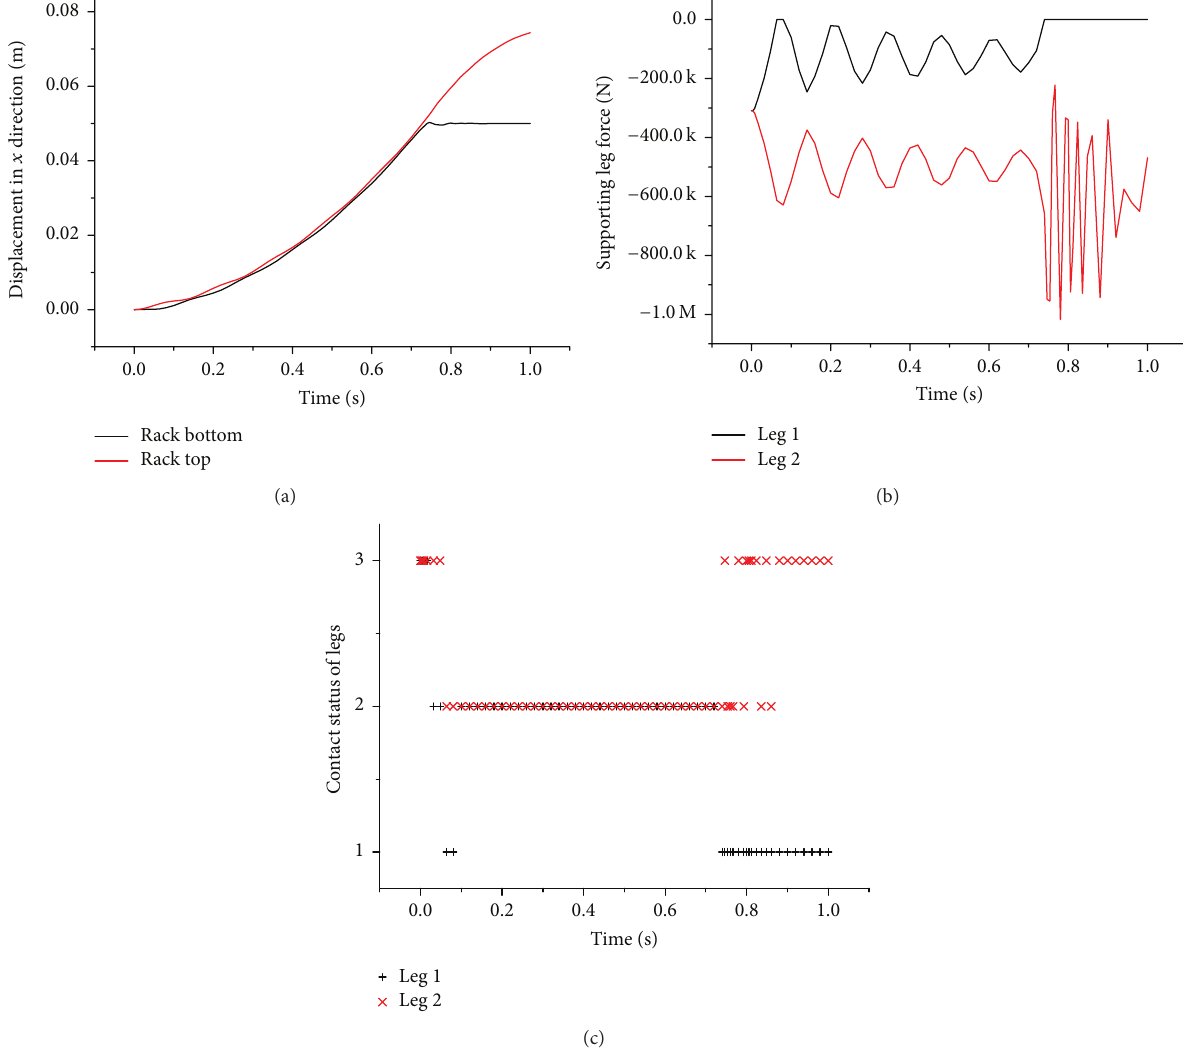
Figure 7: Uniform acceleration amplitude loading: 0.10 g.